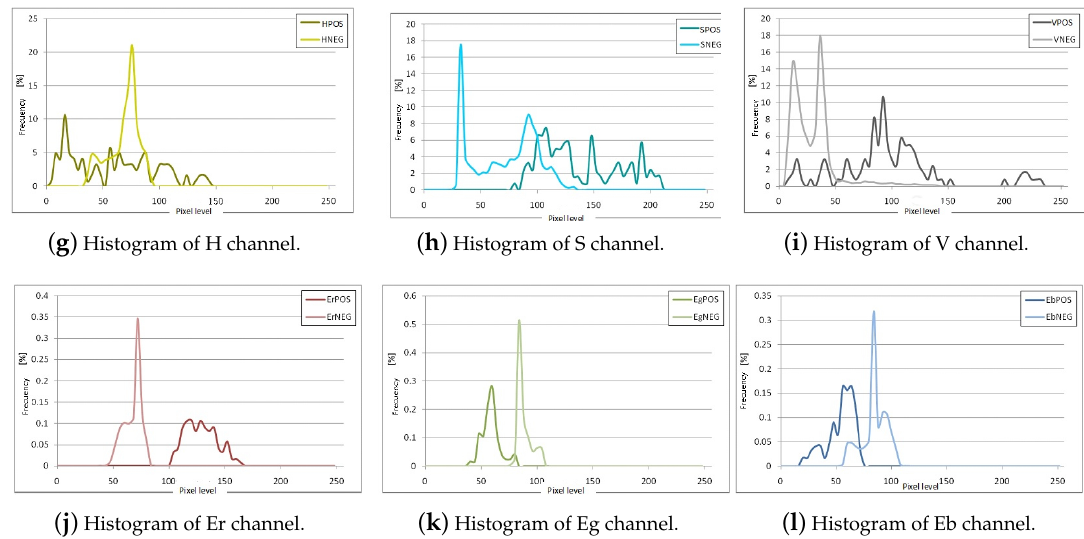
Figure 2. Histograms of the average Stop sign images ( c POS) and their background ( c NEG) for each channel c in the RGB, YCrCb, HSV and ErEgEb color